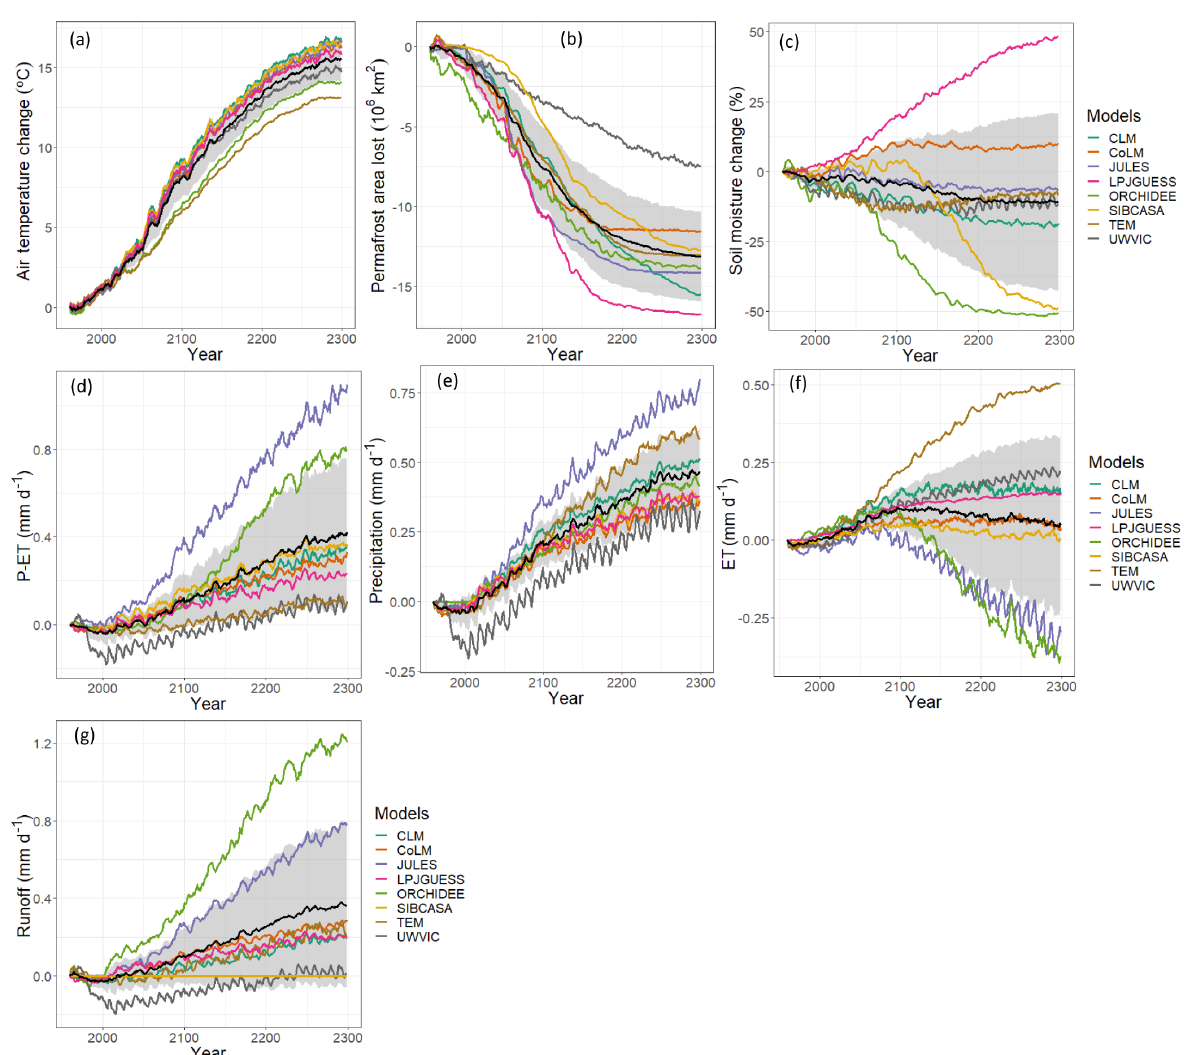
Figure 2. Simulated annual mean changes in air temperature, near-surface permafrost area, near-surface soil moisture and hydrology variables relative to 1960 (RCP 8.5). Annual mean is computed from monthly output values. The black line represents the models’ ensemble mean, and the gray area is the ensemble standard deviation. Panels (d) , (e) , (f) , and (g) are represented as change from 1960 values. Time series are smoothed with a 7-year running mean for clarity and calculated over the initial permafrost domain of each model in 1960 for latitude > 45 ◦